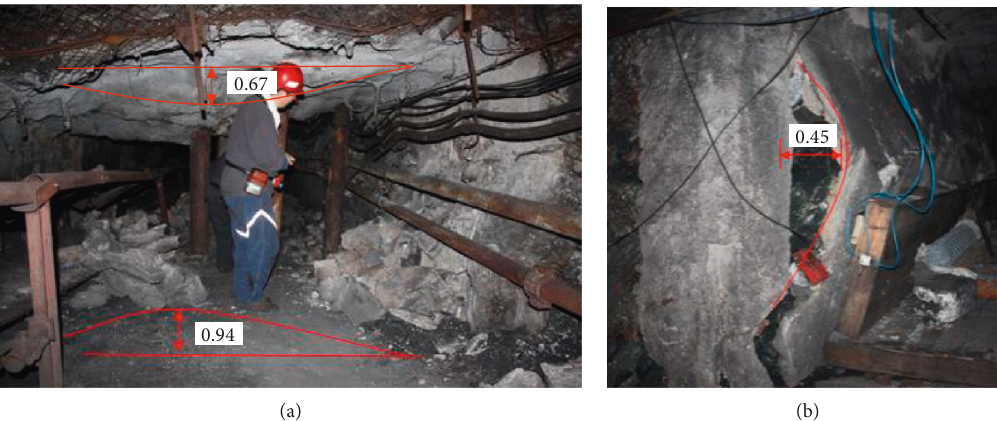
Figure 24: Photos after instability of no. 1 section of prototype roadway; (a) Roof collapse and floor heave; (b) side sliding (unit: